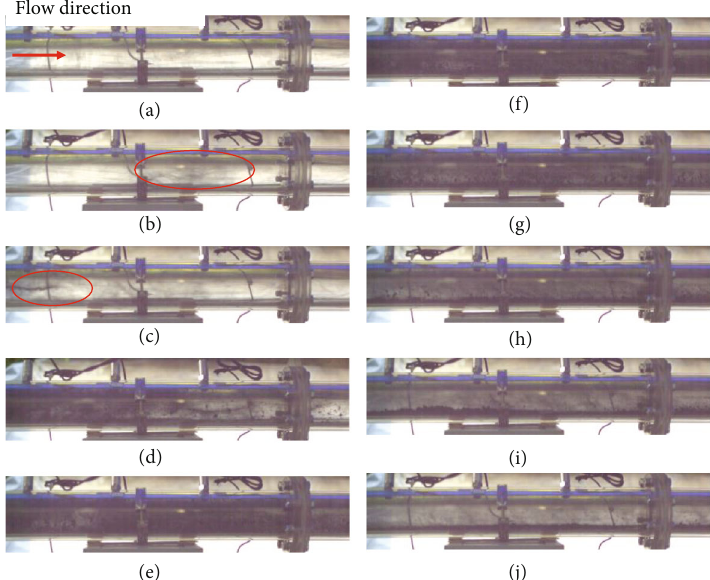
Figure 4: The evolution process of two-phase fl ow in the fi rst section during outburst (0.3 MPa). (a) 0ms; (b) 50ms; (c) 110ms; (d) 250ms; (e) 400ms; (f) 500ms; (j) 600 ms; (h) 800ms; (i) 1000ms; (j) 1400